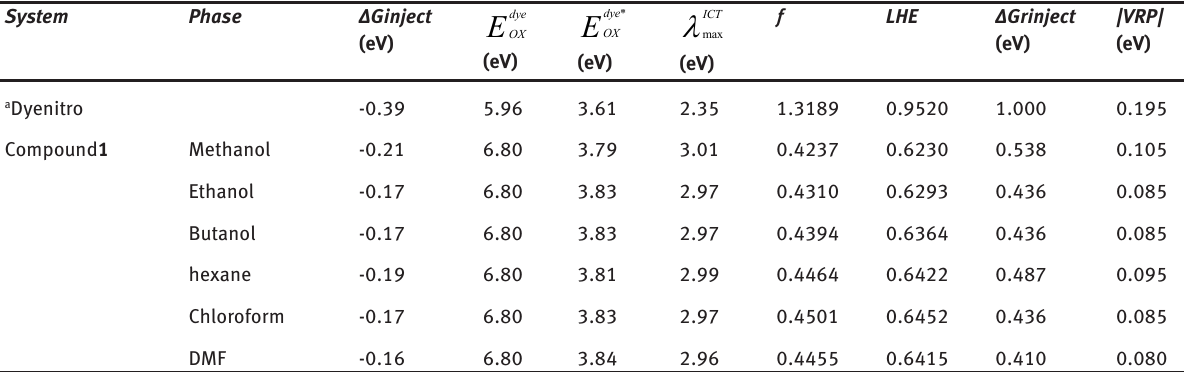
Table 3: he Δ G inject , ΔGrinject , oxidation potential, light harvesting efficiency (LHE), |V TD-B3LYP/6-31G** levels of